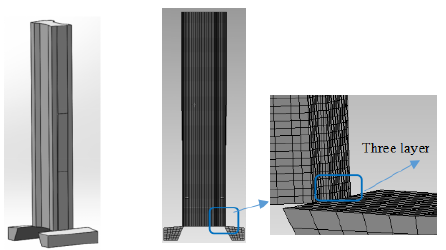
Figure 3. Simulation Model.